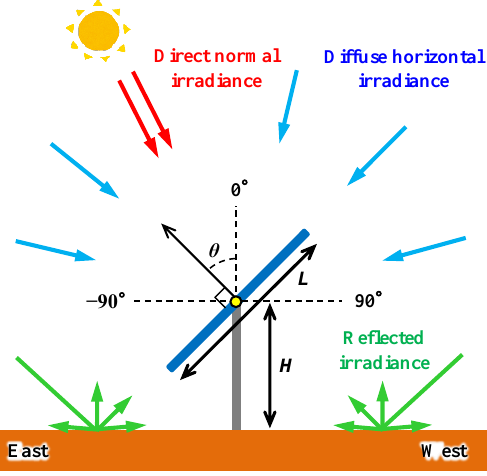
Figure 1. Diagram of virtual 1-axis tracking bifacial photovoltaic (BPV) array.